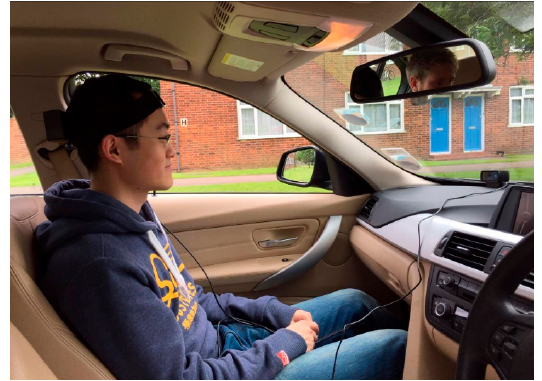
Figure 12. The experiment setup for the in-vehicle tests.